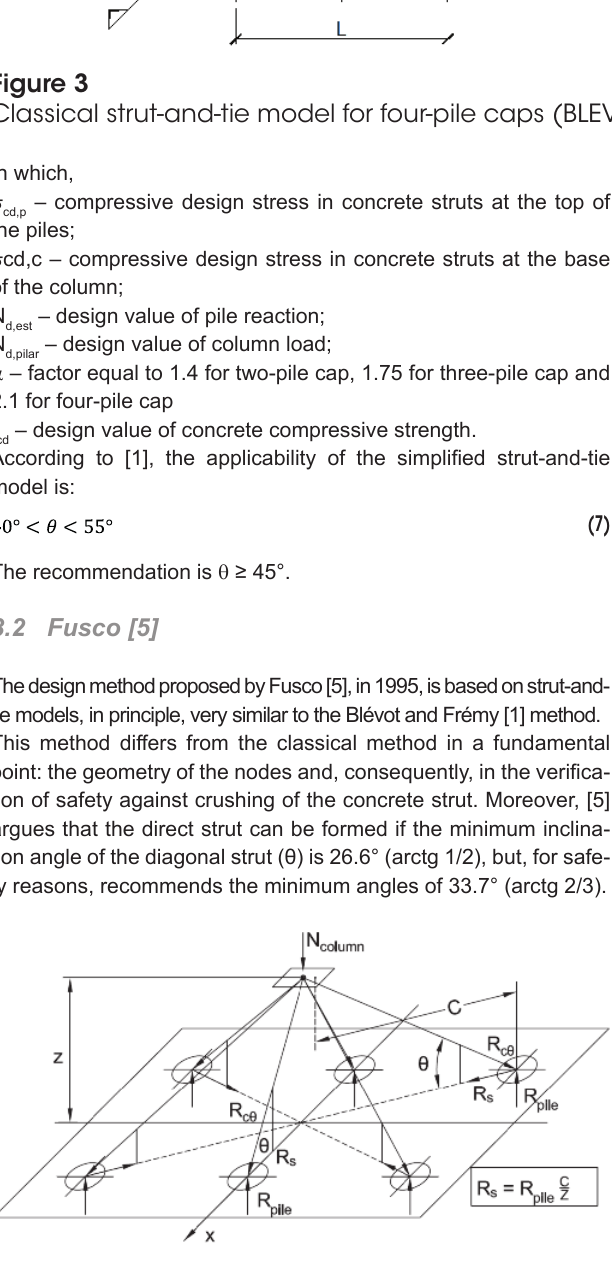
Stresses in the horizontal plan of the pile cap (FUSCO